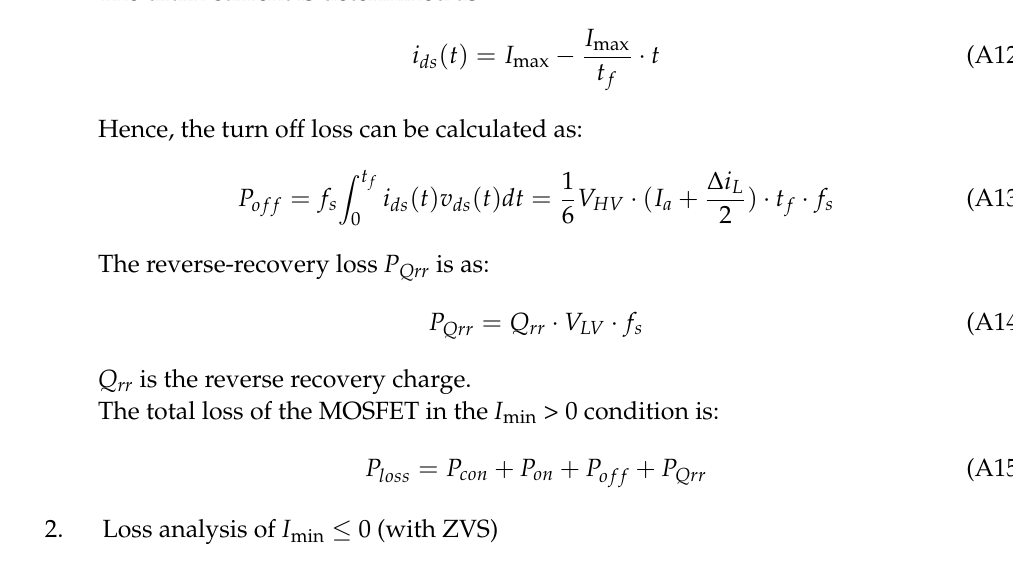
lossless turn on, but as a consequence, there are losses during the turn off event. As long as through the MOSFET is a triangular wave, as shown in Figure A2.